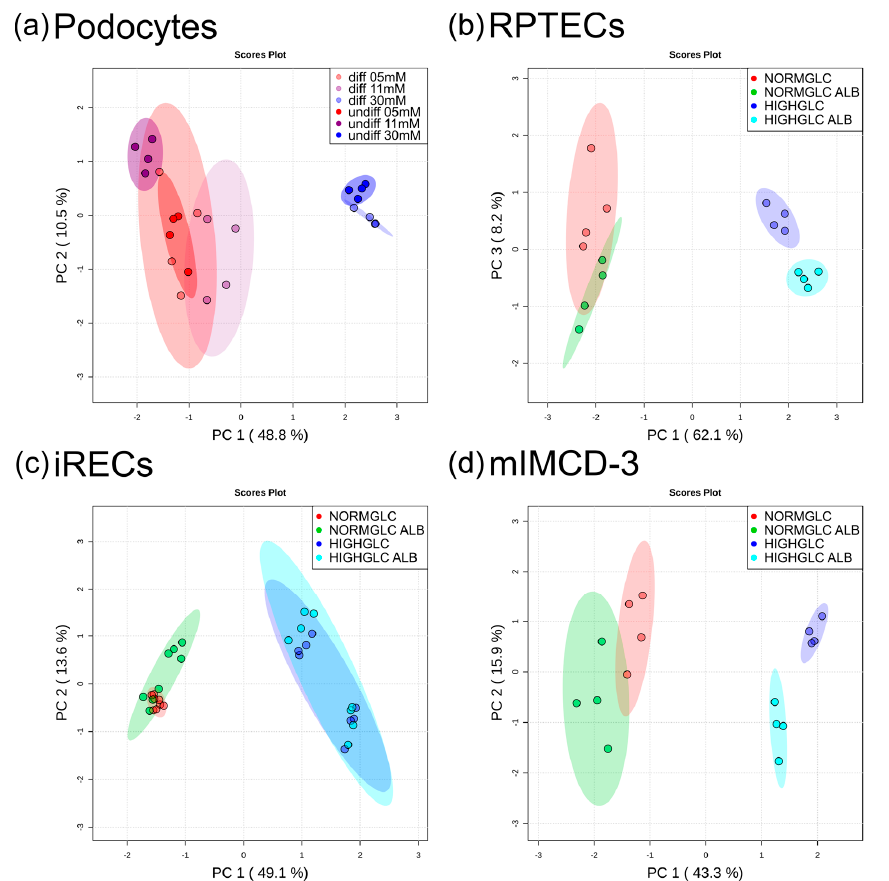
Figure 1. Principal component analysis (PCA) of different cell lines. ( a ) Glomerular cells showed global metabolic alterations upon high glucose treatment. ( b ) Human proximal tubular cells revealed a